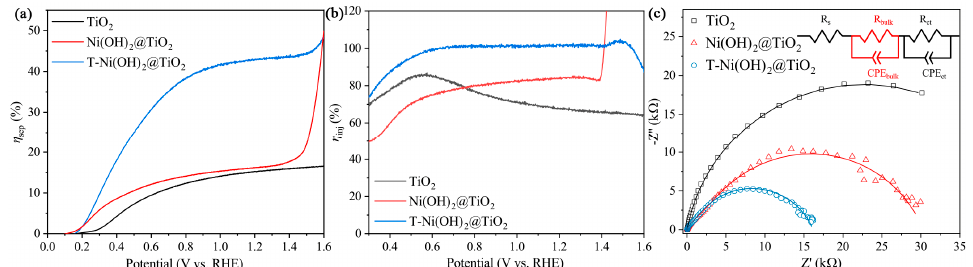
Figure 3. ( a ) Bulk charge separation efficiency and ( b ) surface charge injection efficiency plots of TiO 2 , Ni(OH) 2 @TiO 2 , and T-Ni(OH) 2 @TiO 2 . ( c ) Nyquist plots of TiO 2 , Ni(OH) 2 @TiO 2 , and T-Ni(OH) 2 @TiO 2 photoanodes at 0.8 V RHE in 1 M KOH/0.33 M urea under AM 1.5G illumination. Inset: equivalent circuit for PEIS fitting. Solid line: fitting plot.